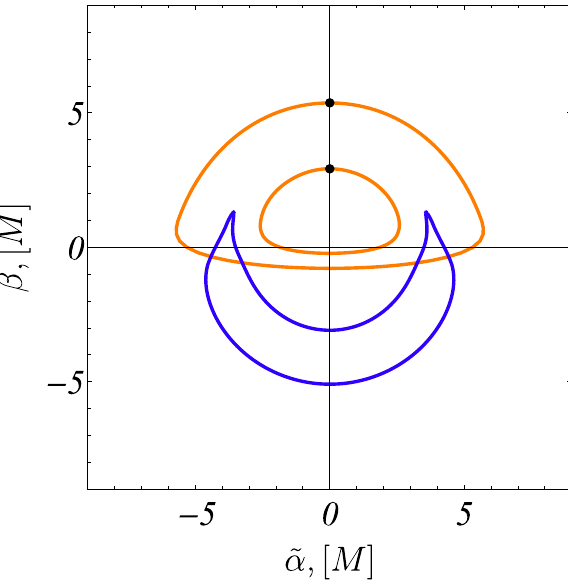
Fig. 14 Image of a point light source (black dots) located at the azimuthal angle φ = π and radial coordinate r = 5 . 896 M in the space- time of the strongly naked singularity with γ = 0 . 48. Comparing with Fig. 13b we see that sources located behind the compact object may have fewer images than those lying in front at the same radial distance